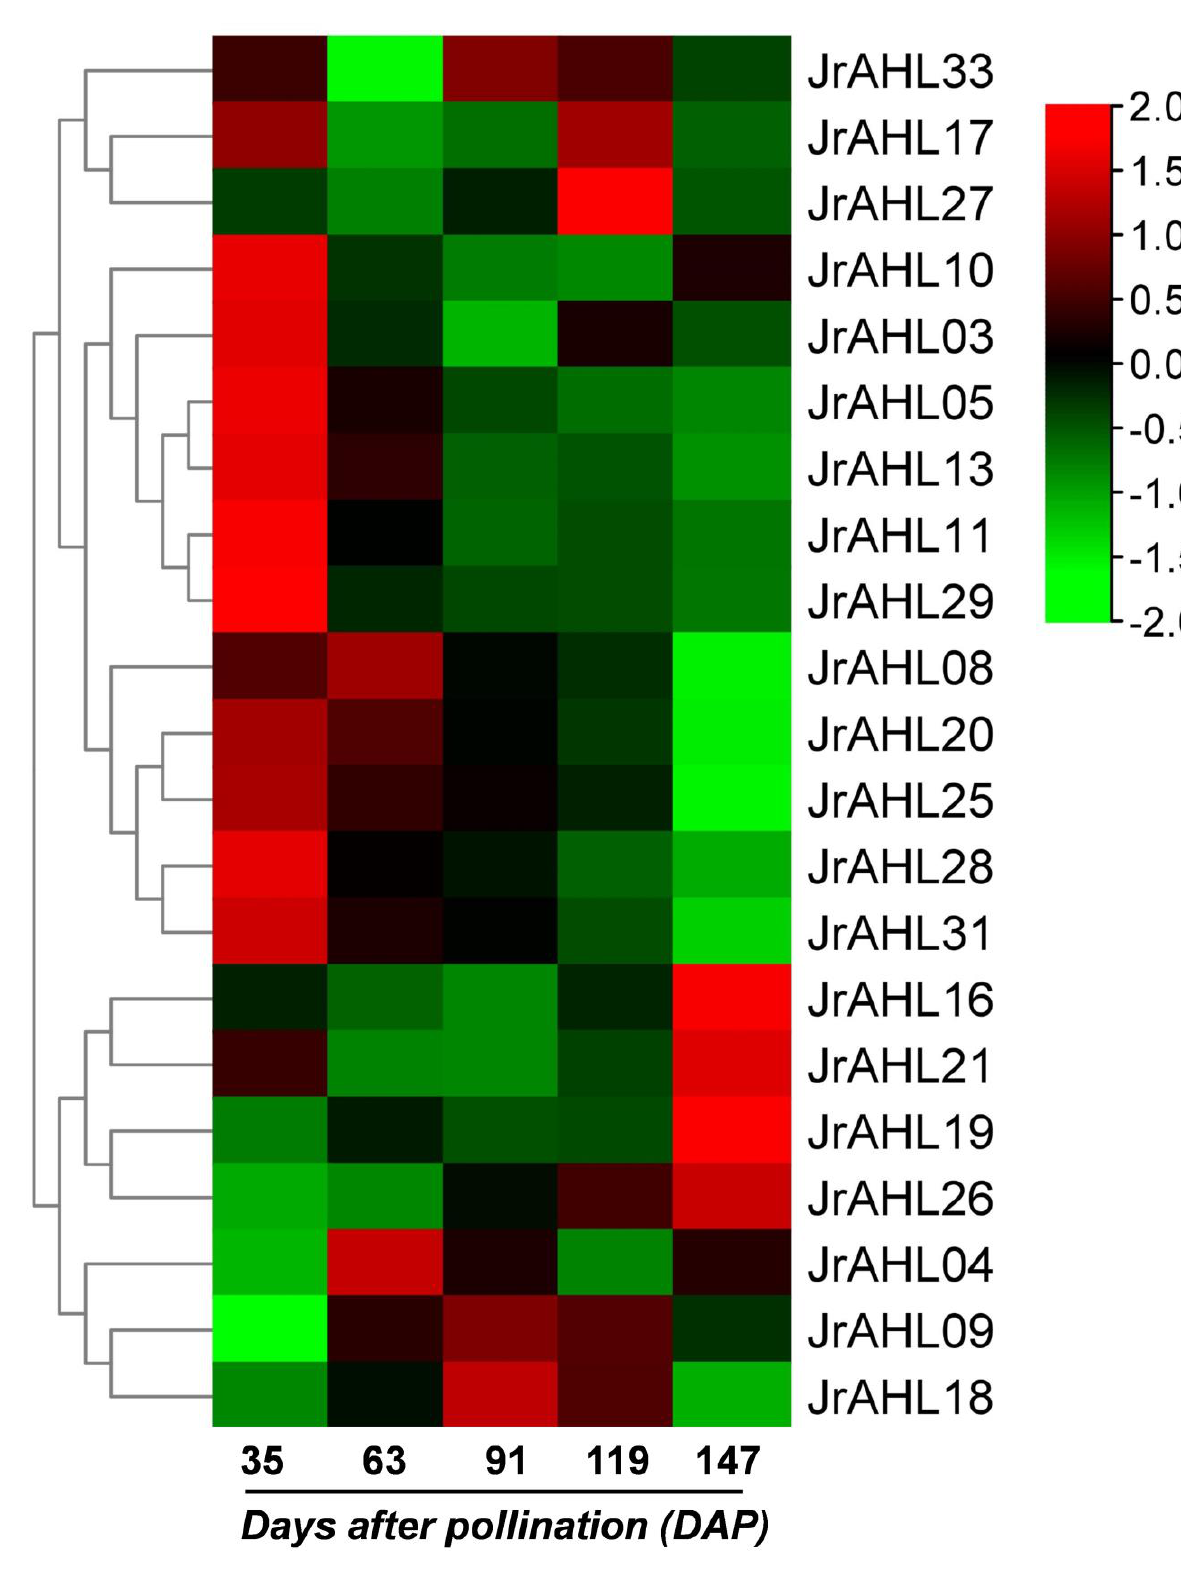
Figure 8. JrAHL gene expression profiles at different developmental stages of endopleura in walnut. The heat map was generated based on the transcriptomic data of the endopleura at different (35, 63, 91, 119, and 147) days after pollination (DAP).